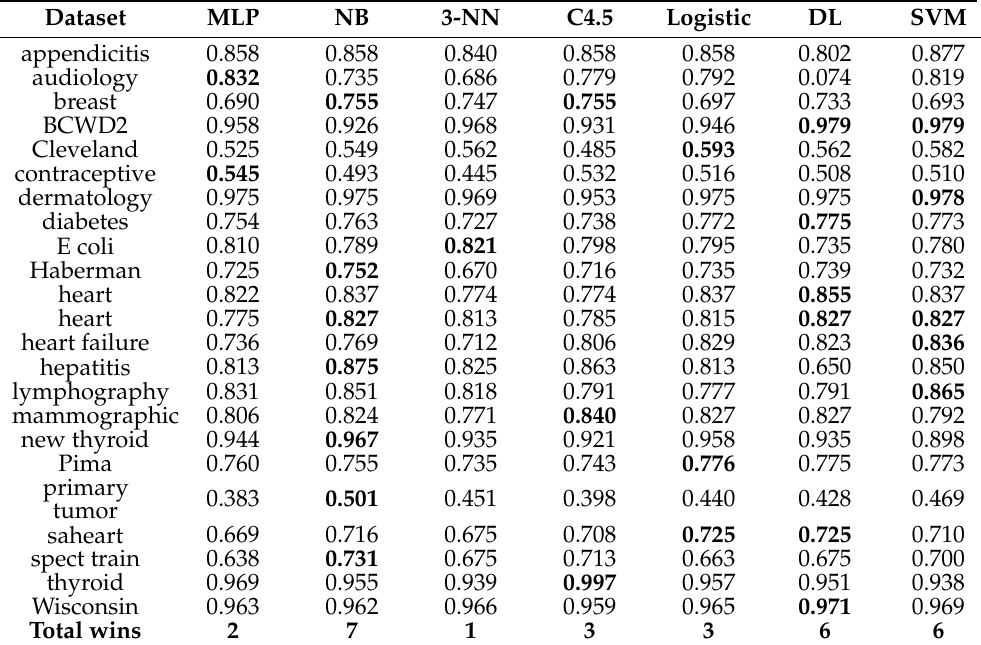
Table 5. Performance of the classifiers using Sensitivity as a metric.